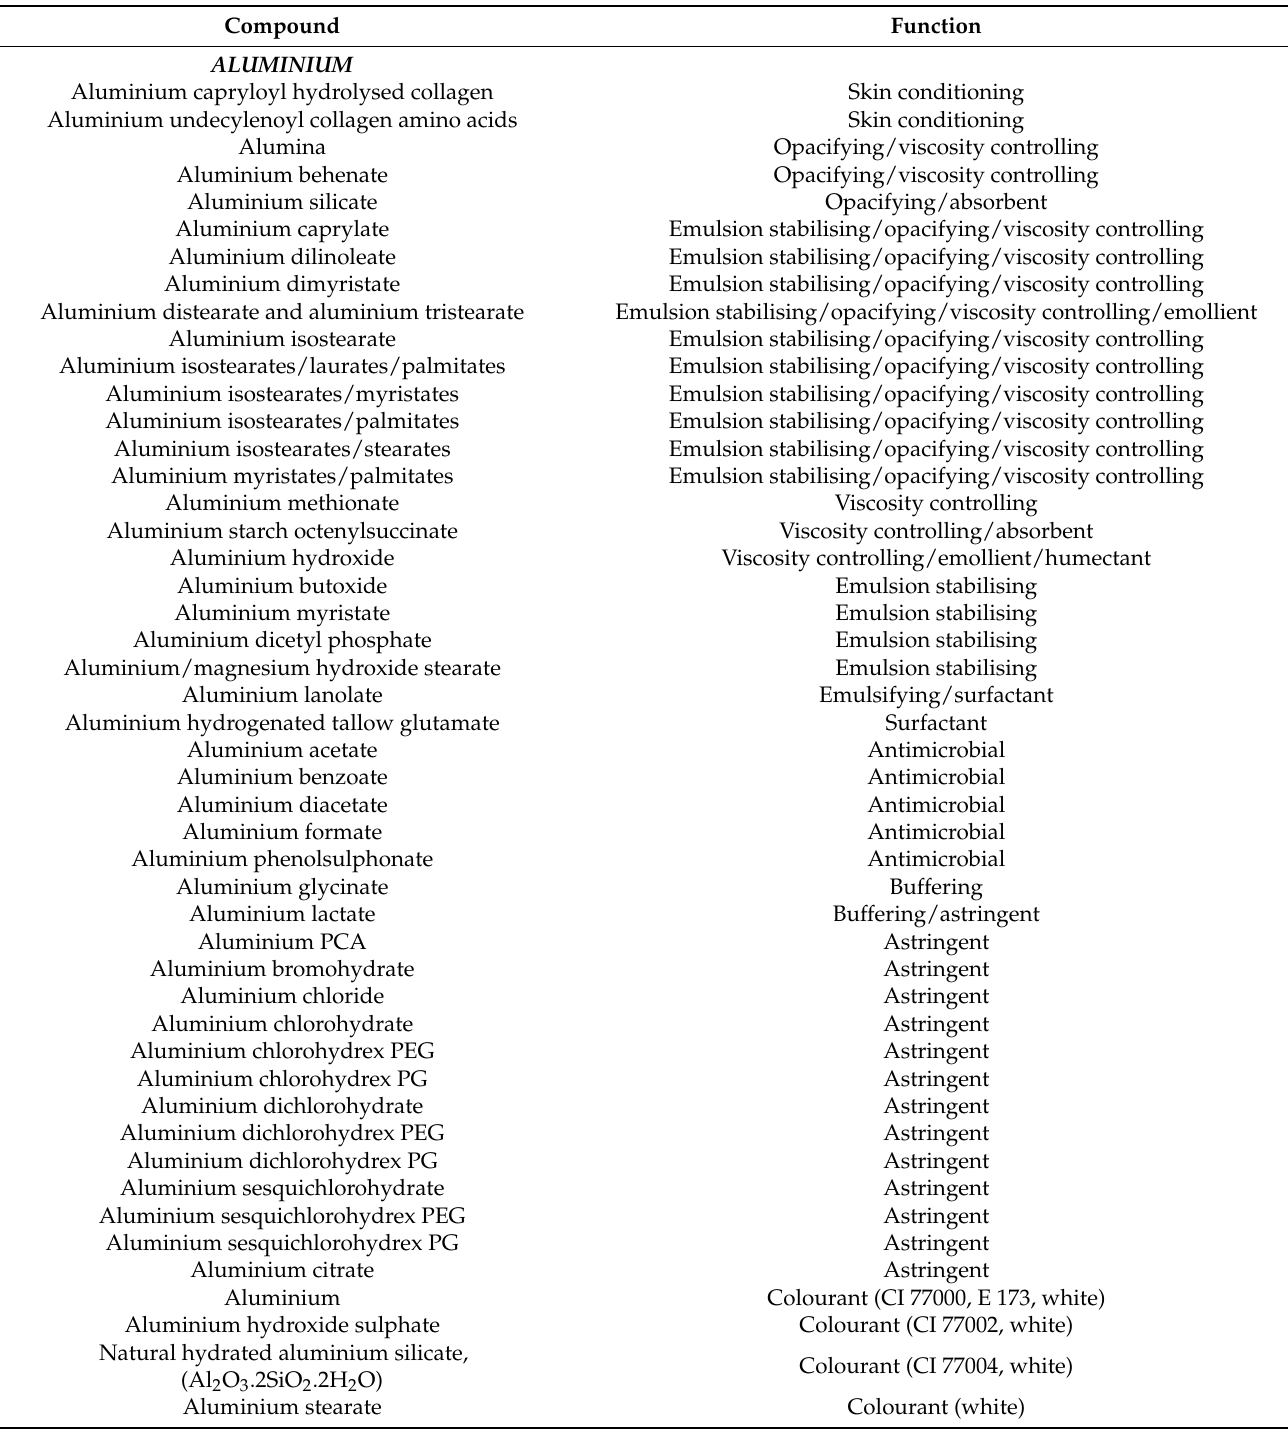
Table 1. Functions of the studied metals in formulations of moisturising creams (adaptation from the European Commission’s inventory of ingredients in cosmetic products [4], considering the metal compounds allowed by Regulation (EC) No. 1223/2009 on cosmetic products